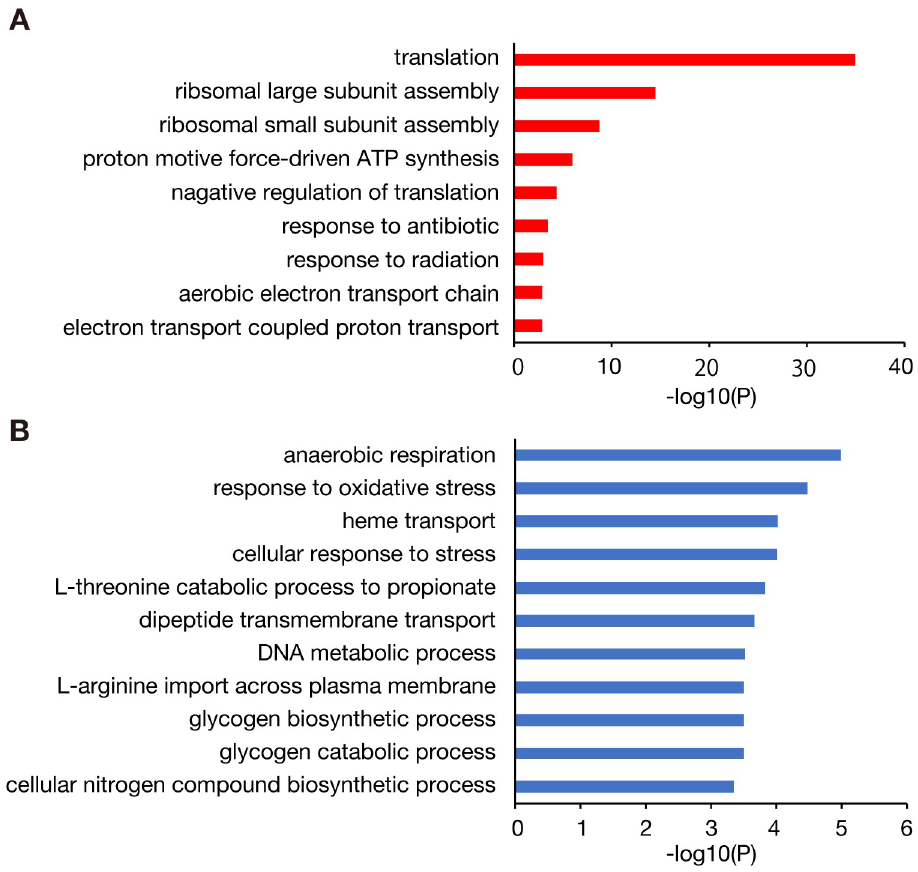
Fig 5. GO enrichment analysis of differentially expressed genes in the rpmJ mutant. GO enrichment analysis was performed using differentially expressed genes in the rpmJ mutant (195 upregulated genes, 275 downregulated genes) (S1 Table). Categories with a p value < 0.001 are shown. GO-enriched categories of genes with increased expression are shown in panel A and categories of genes with decreased expression are shown in panel B.